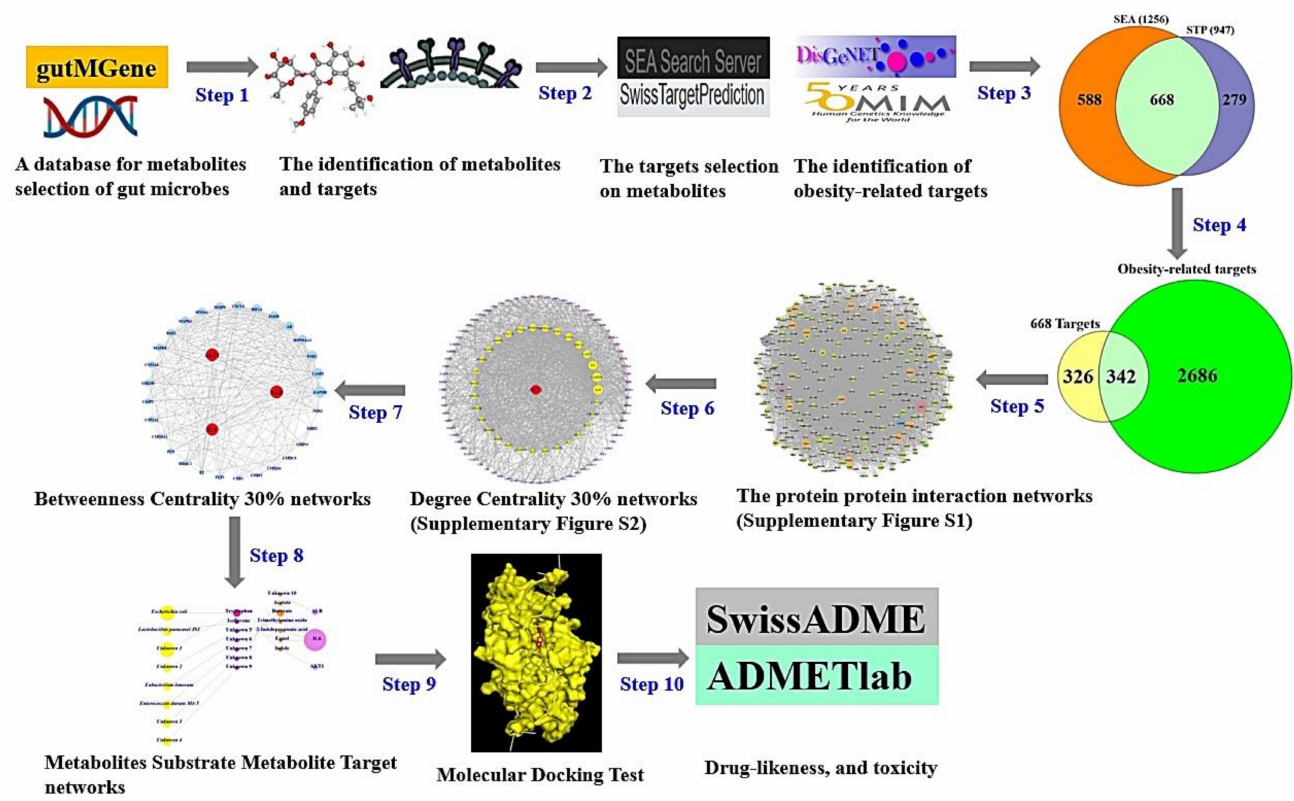
Figure 1. The workflow of this